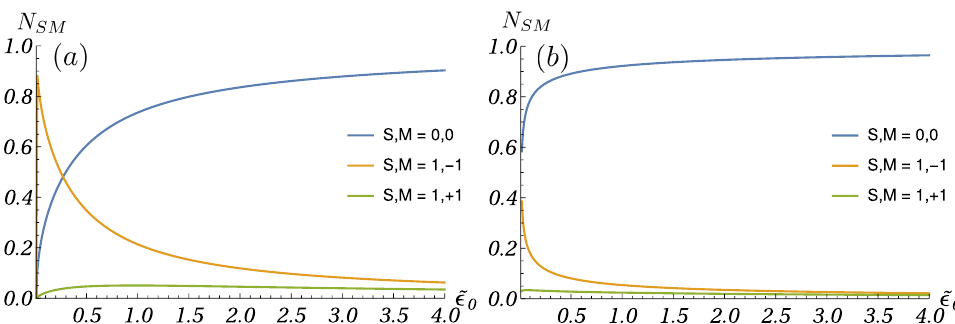
Figure 7: Fractional weights N of total-spin eigenstates in the 2D-fermion bound SM state with zero COM momentum ( P = 0 ) formed at fixed Zeeman energy ˜ h = 1, plotted as a function of the s -wave interaction strength parameterized by ˜ ε type [ panel (a) ] and 1D-type [ panel (b) ] spin-orbit couplings. We do not show N as it vanishes identically in both cases for zero COM